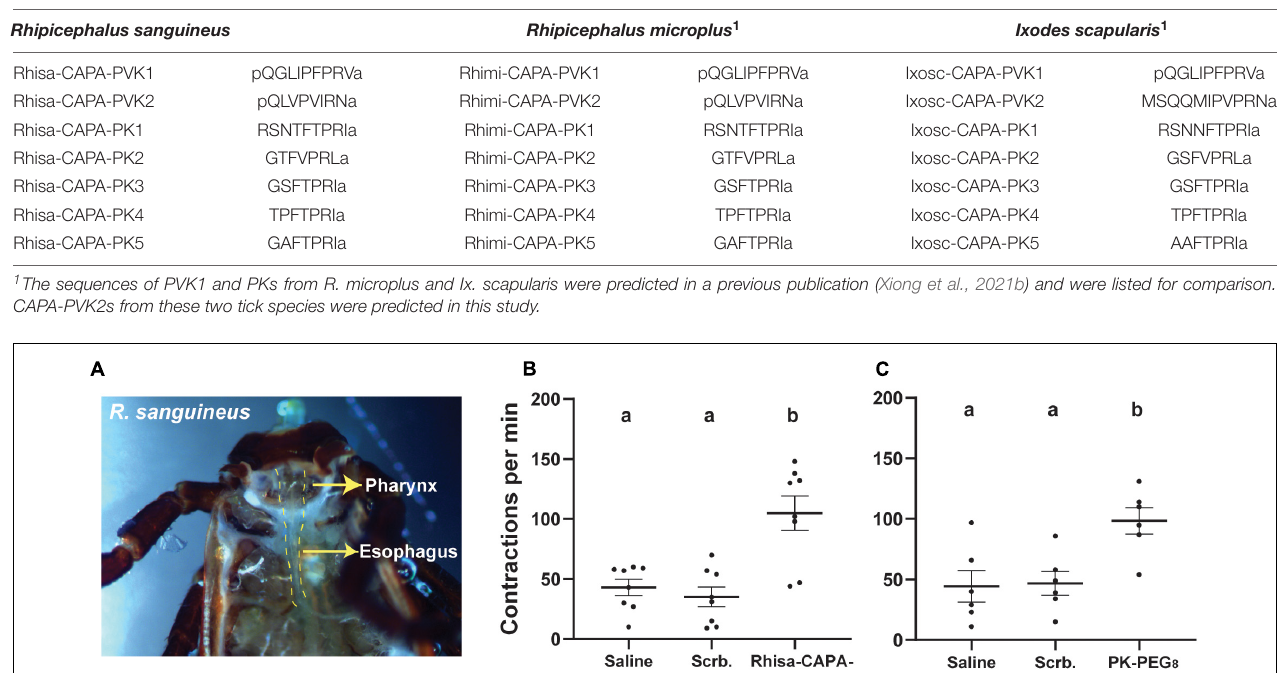
TABLE 2 | Predicted periviscerokinin and pyrokinins from Rhipicephalus sanguineus .